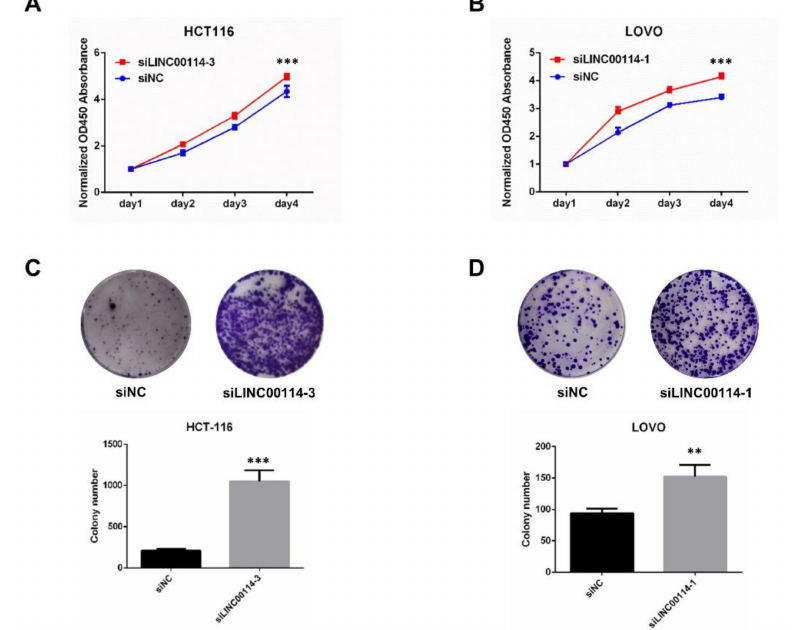
Figure 8. LINC00114 represses CRC cell proliferation. ( A – D ). Cell Counting Kit (CCK)-8 and colony formationassayswereusedtoassesstheroleofLINC00114siRNAinHCT-116orLOVOcellproliferation. All data are expressed as mean ± SD of three independent experiments; ** p < 0.01, *** p < 0.001.